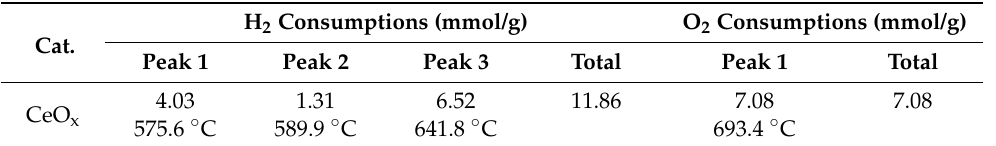
Table 4. H 2 -TPR profiles and O 2 -TPO peaks data.